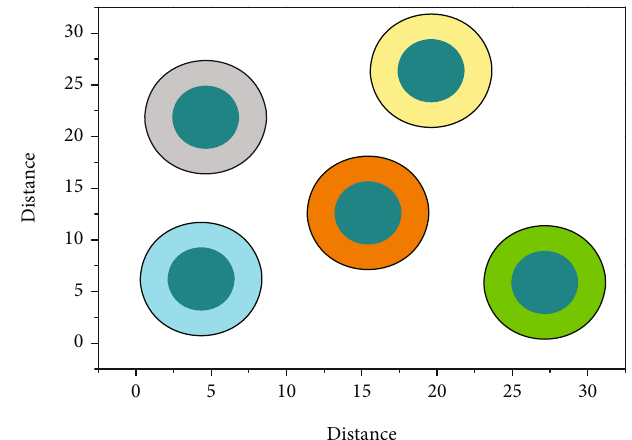
Figure 4: Feature map.